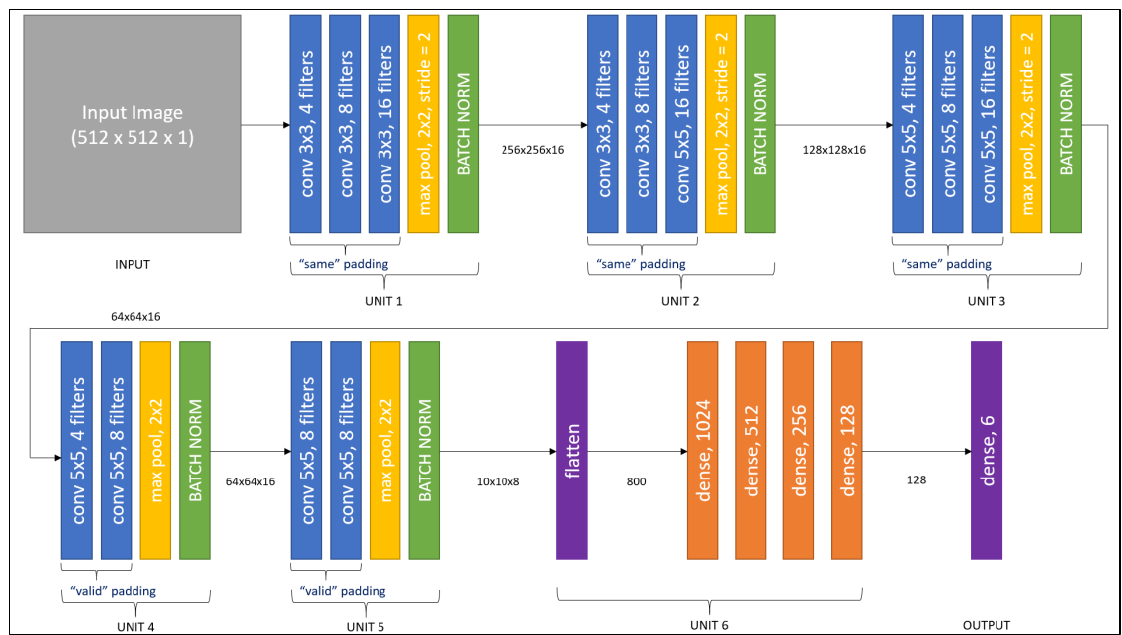
Figure 5. The working architecture of the CNN approach.